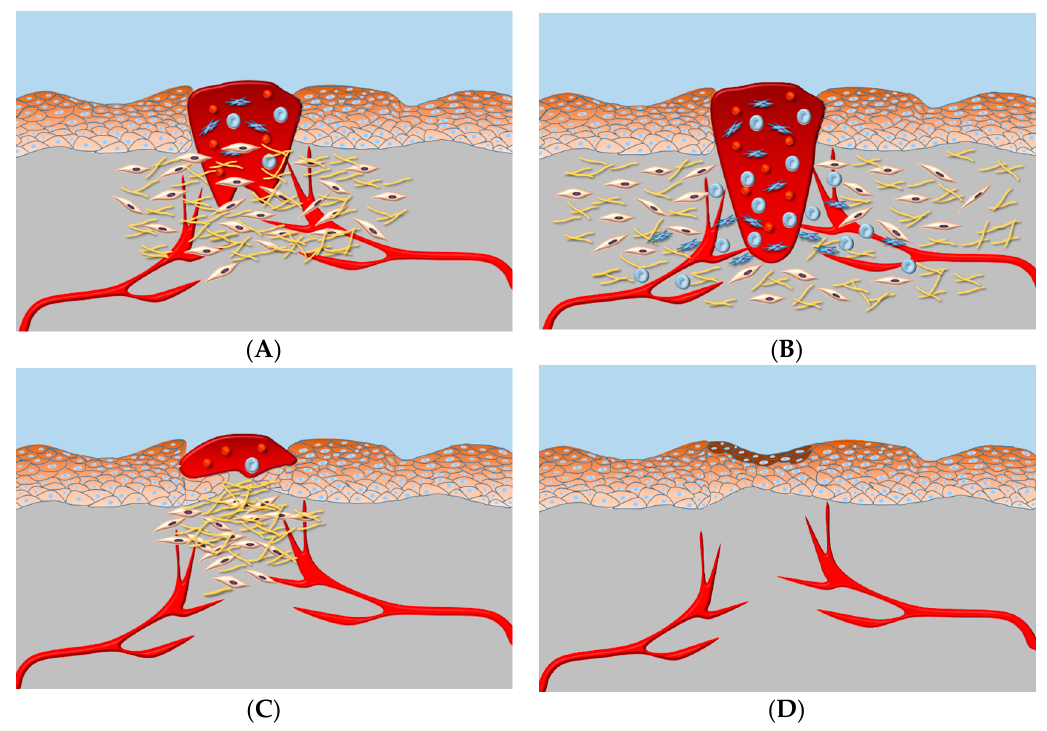
Figure 6. ( A ) The wound causes the formation of the clot (dark red area) and the recruitment of macrophages (blue) and neutrophils (round blue); ( B ) Fibroblasts (white) are also recruited to the wound site to fill it via collagen production (light brown); ( C ) Collagen and fibroblats rebuilt the tissue inducing endothelial cells proliferation and vessel generation; ( D ) Skin stem cells generate mature skin cells obtain the wound closing.